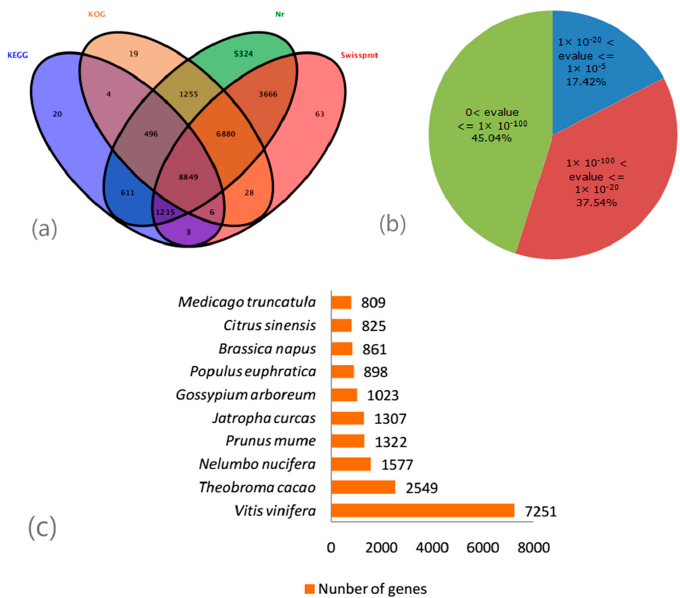
Figure 2. Outcome of homology search of tree peony unigenes against the Nr database. ( a ): Venn diagram of unigene numbers annotated by BLASTx with an E-value threshold of 1 × 10 − 5 against protein databases. The numbers in the circles indicate unigenes numbers annotated by single or multiple databases; ( b ): E-value distribution of the top BLAST hits for each unigene sequence; ( c ): Species distribution of the top BLAST hits for all homologous